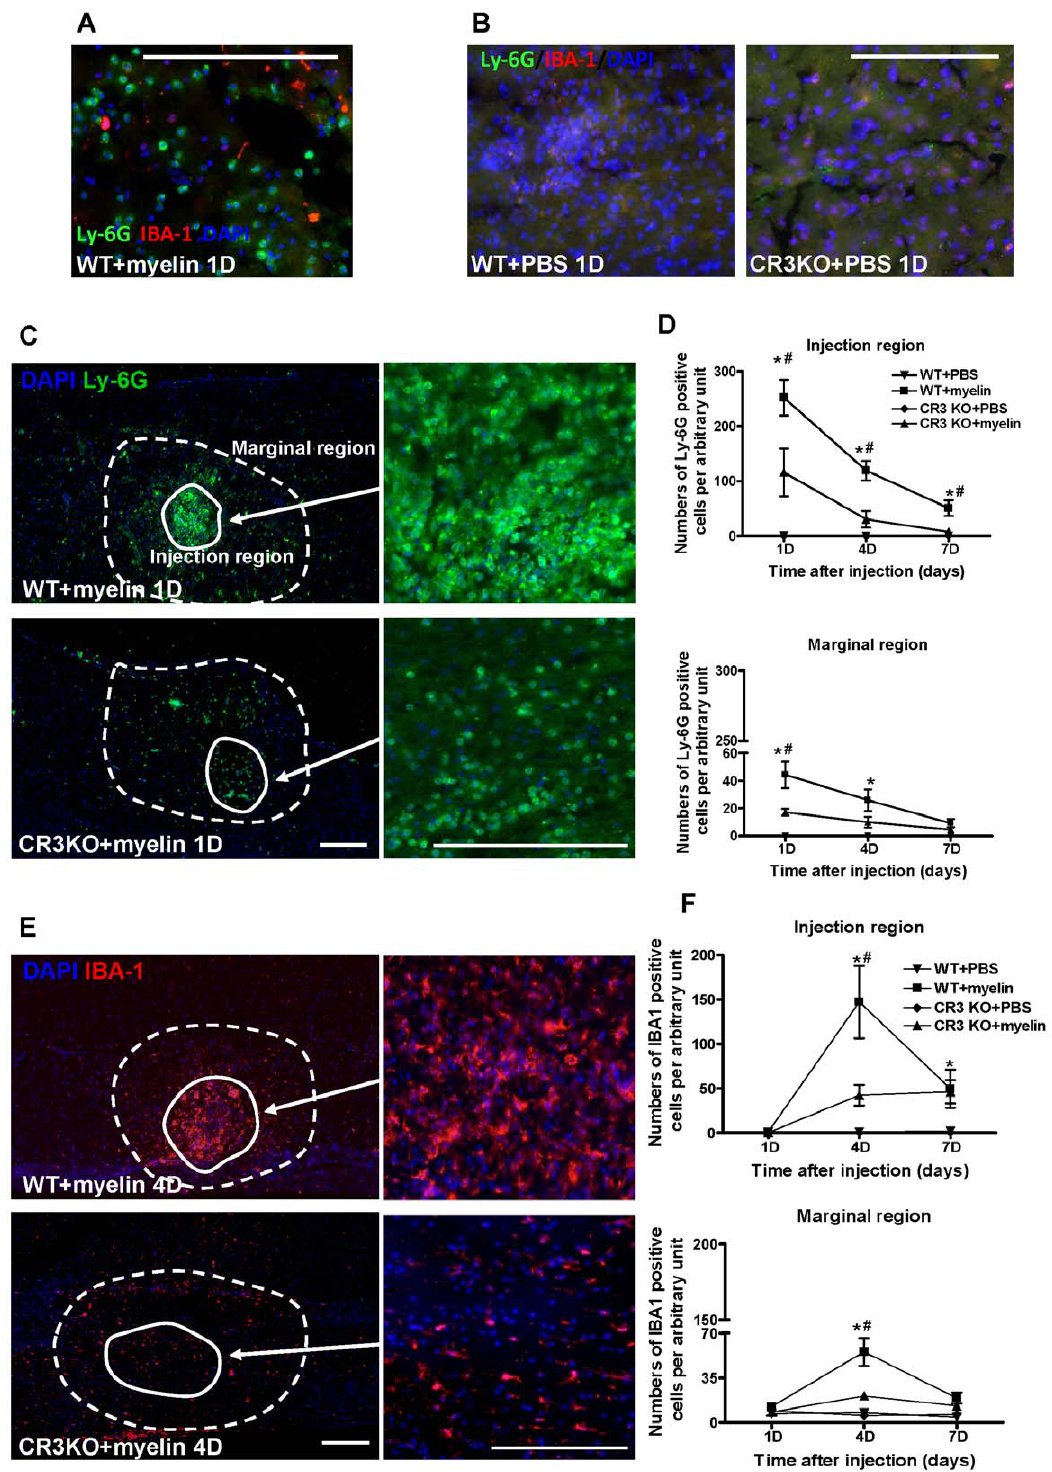
Figure 2. Inflammatory effect of myelin in spinal cord from WT and CR3 KO mice. (A) Neutrophils were positive for Ly-6G (green) but negative for IBA-1 (red) detected by double immunostaining. (B) Neutrophil and macrophage infiltration in spinal cord at 1 d after PBS injection detected by double immunostaining. (C) Neutrophil infiltration (Ly-6G + , green) in spinal cord at 1 d after myelin injection, along with injection region (solid line), marginal region (dashed line) and enlarged injection region. (D) The number of neutrophils at injection region and marginal region in spinal cord at 1 d after myelin or PBS injection. (E) Macrophage infiltration (IBA-1 + , red) in spinal cord at 4 d after myelin injection, along with injection region (solid line), marginal region (dashed line) and enlarged injection region. (F) The number of macrophages at injection and marginal region in spinal cord at 4 d after myelin or PBS injection. Scale bar=200 m m. Data were expressed as mean 6 SEM. (n=4 at each time point, *P , 0.05 vs. WT + PBS; # P , 0.05 vs. CR3 KO + myelin; t -test).